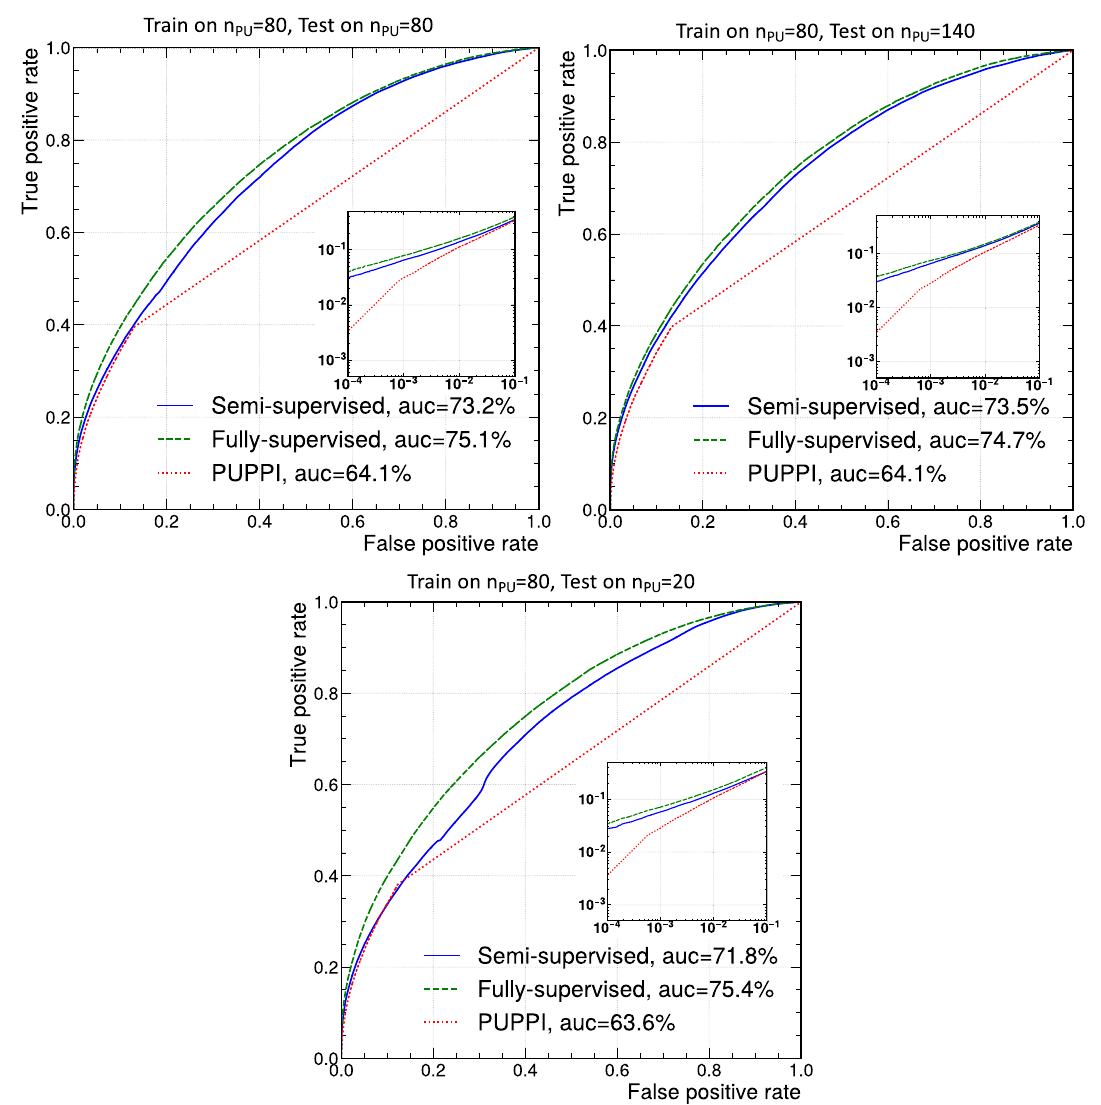
Fig. 3 The ROC curves for the gated GNN on neutral particles under n PU = 80 for SSL, fully-supervised learning, and the domain PUPPI algorithm. The small plot inserted under the ROC curve is the log scale of the lower left region of the ROC curve for better